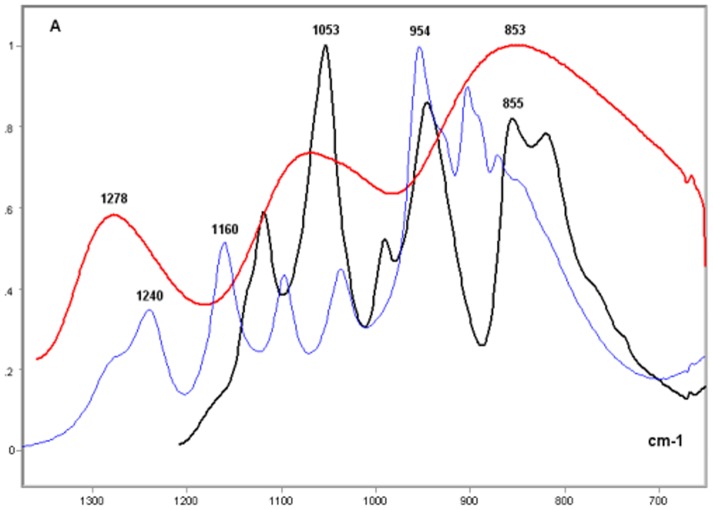
FT-IR spectral profiles of NaH2PO4, Na2HPO4, and KH2PO4.KH2PO4, red line; NaH2PO4, blue line; Na2HPO4, black line; X axis, wavenumbers in cm−1; Y axis, absorbances (A).